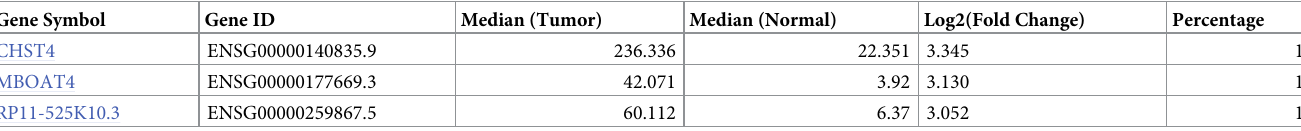
Table 1. Information of the three DEGs from the